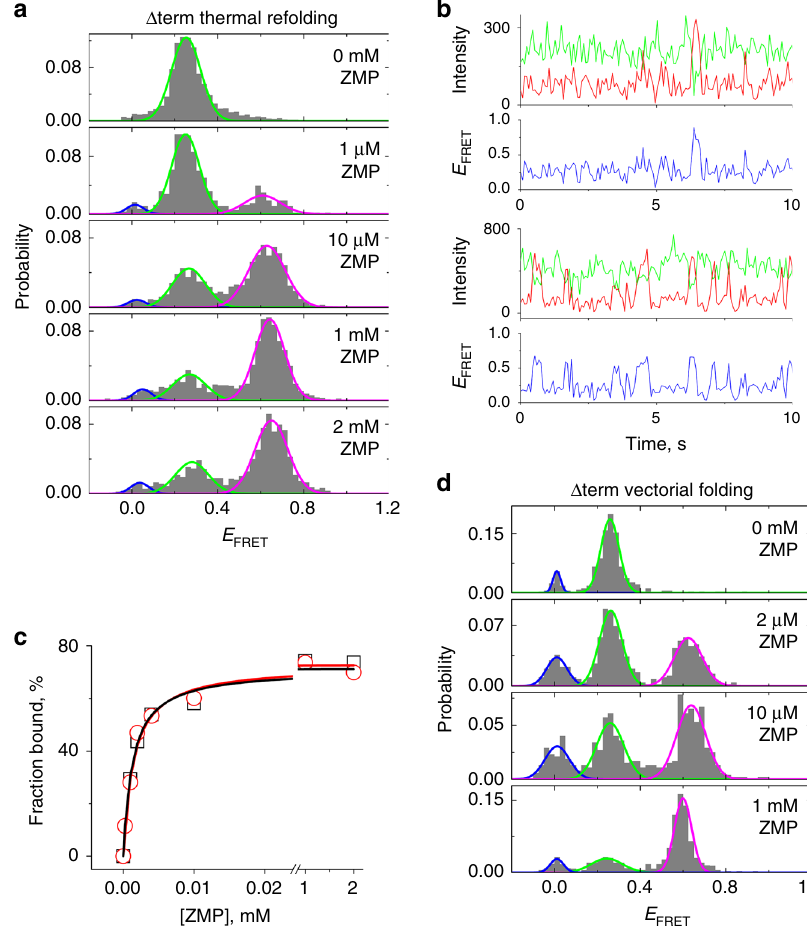
Fig. 2 ZMP binding to the ZTP riboswitch aptamer after thermal refolding and vectorial folding. a The 75-nt ZTP riboswitch aptamer domain ( Δ term) was thermally refolded at 0 mM ZMP and then incubated with different concentrations of ZMP. Gaussian fi tting with global constraints was used to determine the relative population of the ZMP-bound (magenta) vs. ZMP-unbound (green) aptamer. The zero- E FRET state (blue) was also fi t to account for a small fraction (~5 %) of annealed RNA due to remaining splint ssDNA from sample preparation. b Example single-molecule trajectories of thermally refolded Δ term in the absence of ZMP (top) and in the presence of 1 mM ZMP (bottom). Intensities of Cy3 (green), Cy5 (red), and the resulting E FRET (blue) are shown. c The percentage of ZMP-bound aptamer plotted against ZMP concentration and fi tted to the Langmuir function for thermally refolded (black) and vectorially folded (red) Δ term. The apparent K D and maximum percentage ( P max ) were determined to be 1.3 μ M and 71%, respectively, for thermally refolded and 1.5 μ M and 73% for vectorially folded. d E FRET histograms of Δ term after VF at 0 mM ZMP and incubation with different concentrations of ZMP. Here, a multiple turnover VF protocol was used to maximize the amount of unwound Δ term (Online Methods). Global fi ts were performed as in b